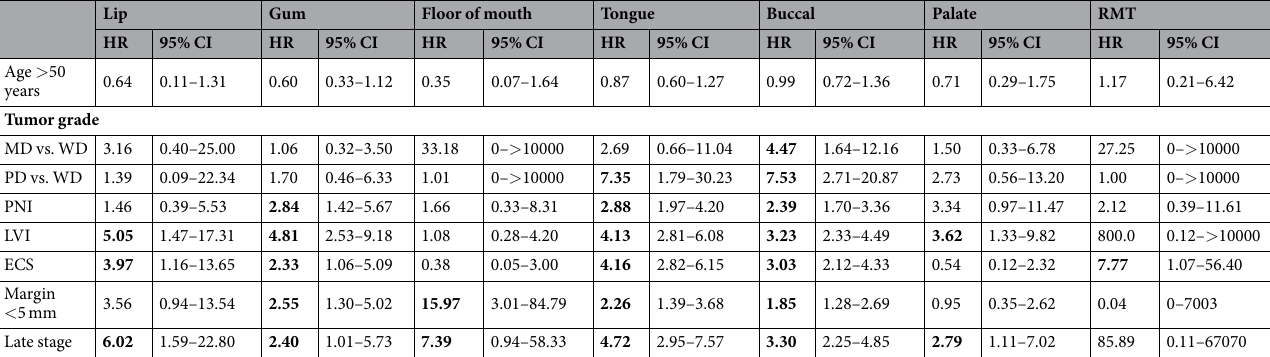
Table 2. Univariate analysis of the impact of clinic-pathological features on the survival of oral squamous cell carcinoma patients based on subsites. Abbreviations: RMT, retromolar trigone; HR, hazard ratio; CI, confidence interval; WD, well differentiated; MD, moderately differentiated; PD, poorly differentiated; PNI, perineural invasion; LVI, lymphovascular invasion; ECS, extra-capsular spread.